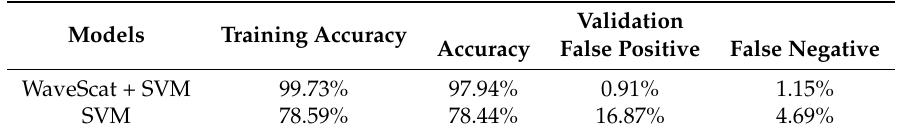
Table 1. Accuracy and confusion results of vertical traces with or without wavelet scattering networks in the machine learning model.